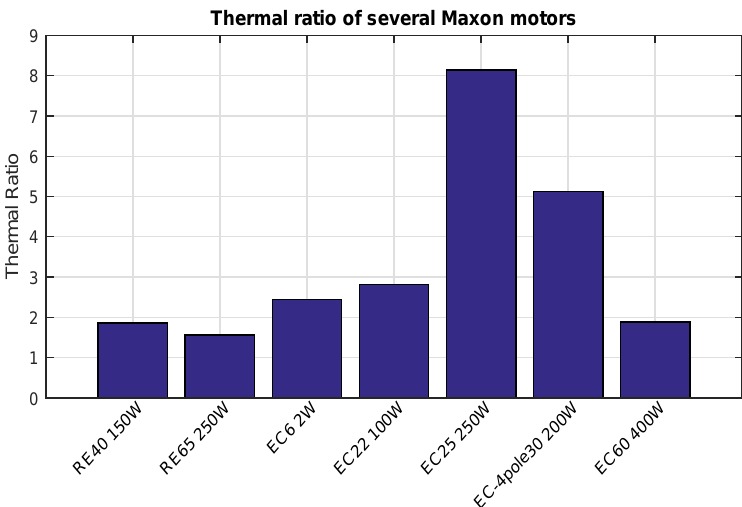
Figure 2. Thermal ratios of several Maxon motors. The thermal ratio is the theoretical improvement factor in continuous current of liquid cooling versus air cooling. Part numbers beginning with ‘RE’ are brushed DC motors, while part numbers beginning with ‘EC’ are brushless DC